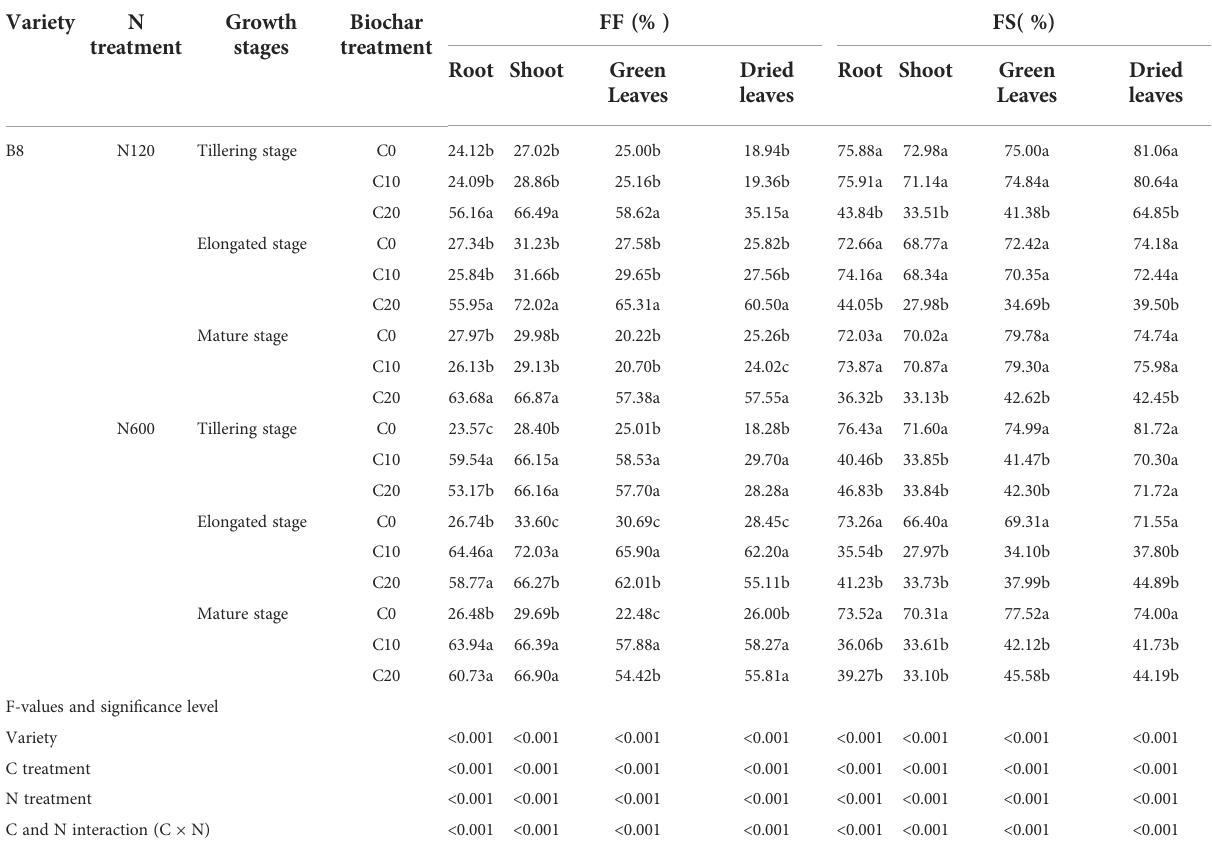
TABLE 3B Effects of biochar and N fertilizer treatment on FF and FS of B8. Variety N